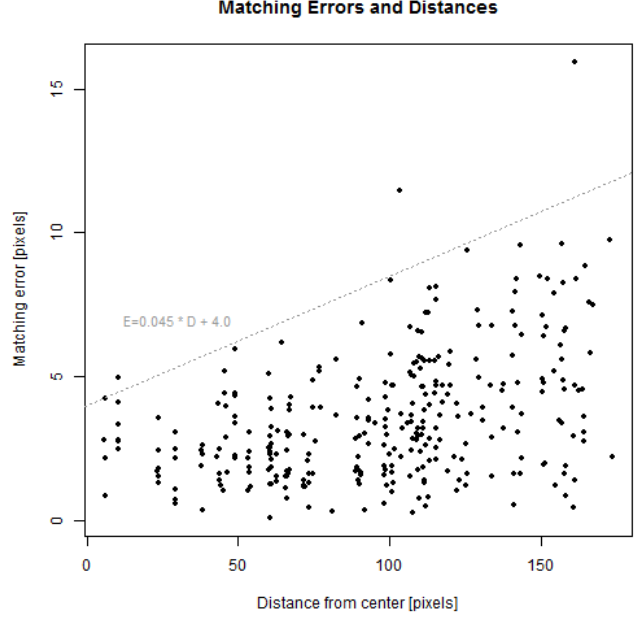
Figure 20. Matching errors in test